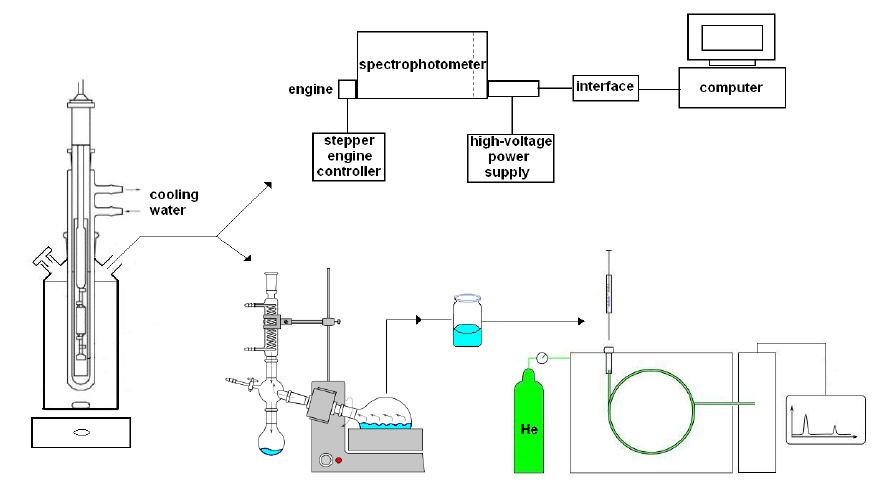
Figure 1. Schematic diagram of experimental